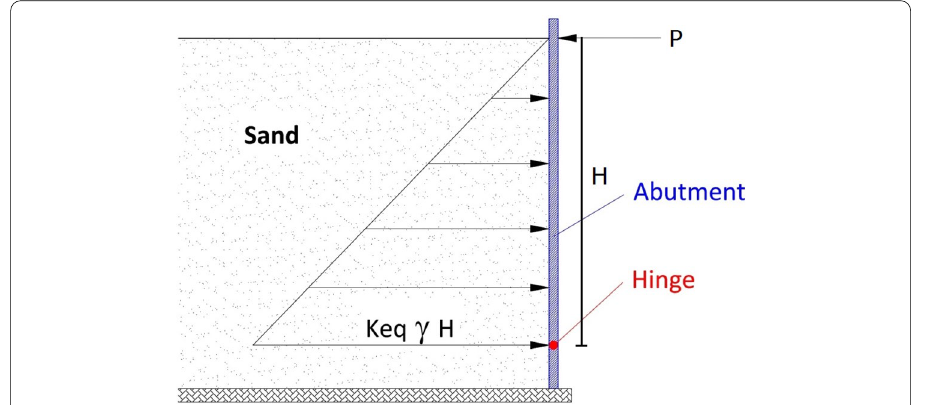
Fig. 11 Distribution (assumed) of the soil pressure required to equilibrate the force P applied on the